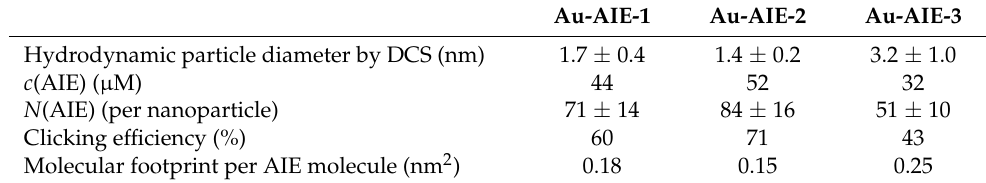
Table 1. Analytical data of AIE luminophores, clicked to gold nanoparticles at c (NP) = 617 nM (30 mg L − 1 Au). To compute the number of AIE molecules on each particle, the diameter of the solid core was set to 2 nm, as known from HRTEM data [39]. The clicking efficiency was defined as the ratio of the number of clicked AIE ligands to the number of available azide groups (118) on each particle [39]. Note that the hydrodynamic diameter by DCS also includes the ligand shell.